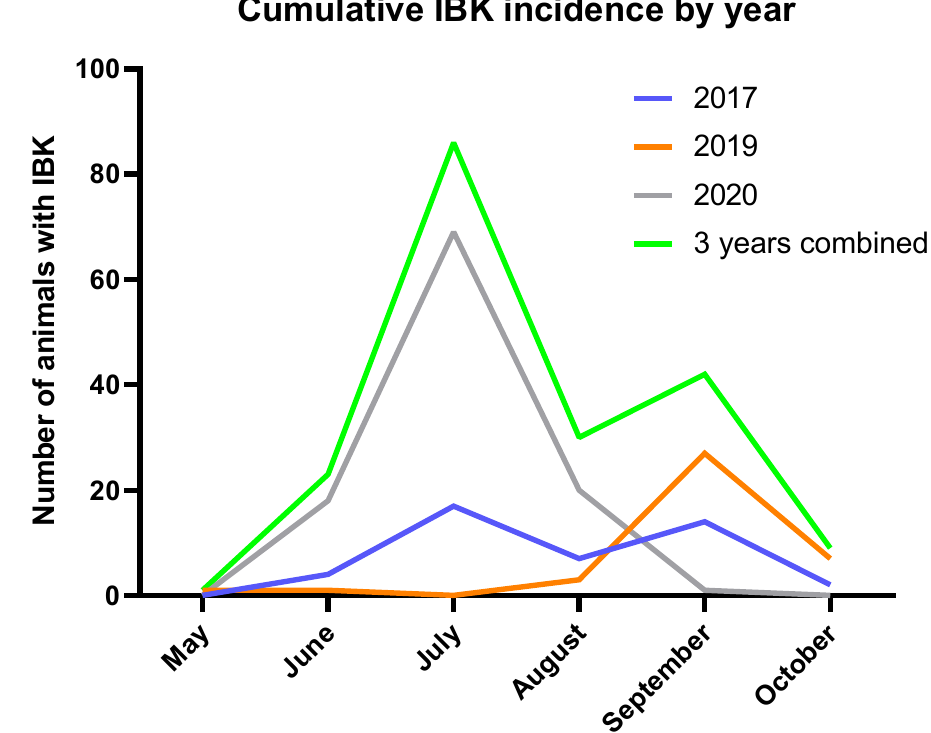
Figure 1. Cumulative IBK incidence by month for years 2017, 2019, and 2020.